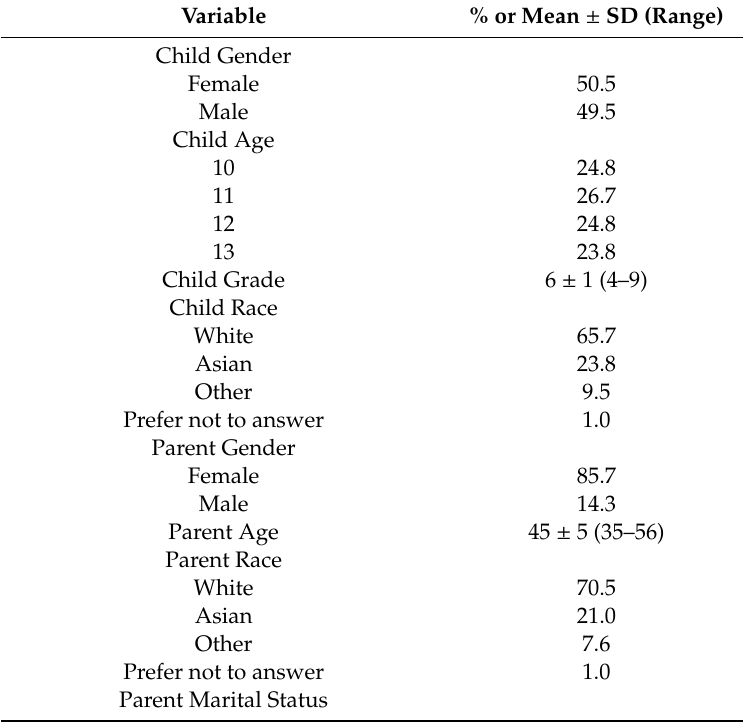
Table 2. Demographic Characteristics (N =